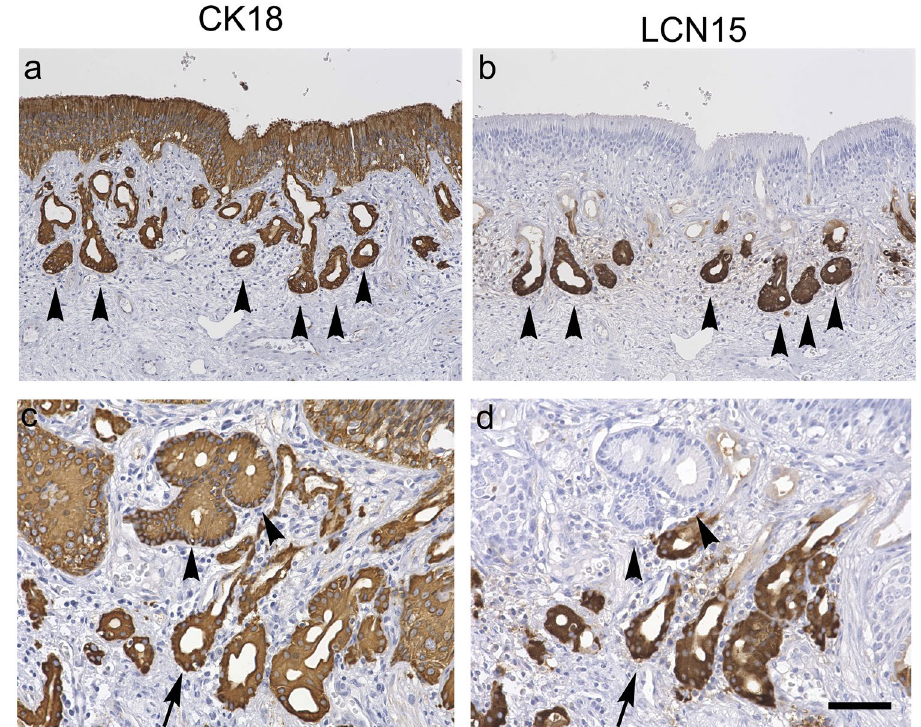
Figure 3. ( a , b ): Magnified views of the serial human olfactory mucosa sections, stained with rabbit anti- cytokeratin 18 antibody ( a ) and rabbit anti-LCN15 antibody ( b ). Black arrows in a and b indicate identical acini of the glands. CK18 immunoreactivity was observed in the whole thickness of the epithelium, ducts of the submucosal glands, and acini of the glands ( a ). In comparison with A, LCN15 immunoreactivity is observed only in the acini of the submucosal glands ( b ). ( cd ): LCN15-negative glands in the superior area of the olfactory cleft. Magnified views of the serial human olfactory mucosa sections stained with rabbit anti-cytokeratin 18 antibody ( c ) and rabbit anti-LCN15 antibody ( d ). A black arrow and arrowheads in c and d indicate identical acini of the glands. LCN15-negative glands appeared to have less dense CK18 staining, and the nuclei of the acinar cells were located adjacent to the basal membrane. Scale bar in d (also applies to a – c ) = 100